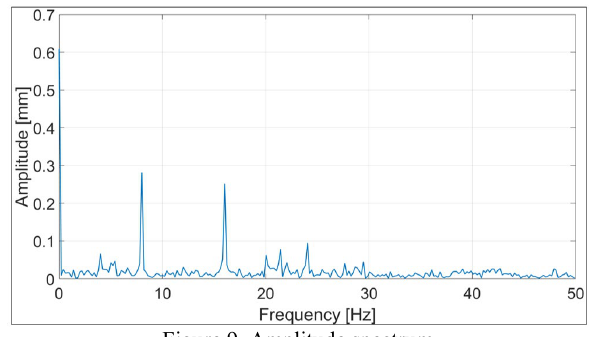
Figure 9. Amplitude